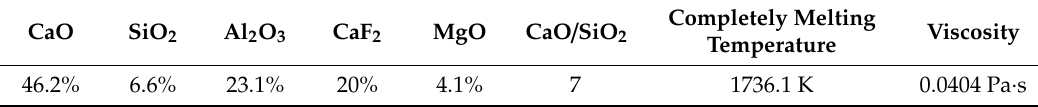
Table 4. The composition and characteristic of slag used for deoxidation.